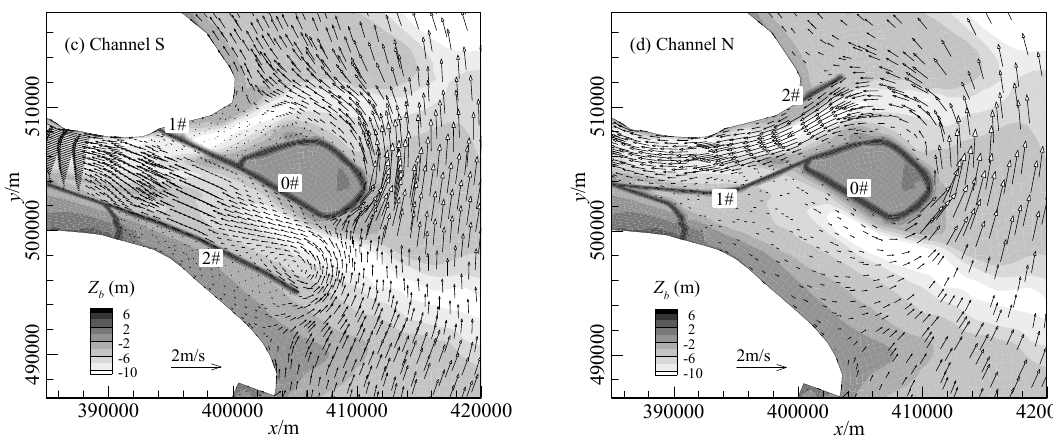
Figure 9. Velocity fields under different designs at a time during flood-ebb transition ( t = 15 h). Water 2019 , 11 , x FOR PEER REVIEW